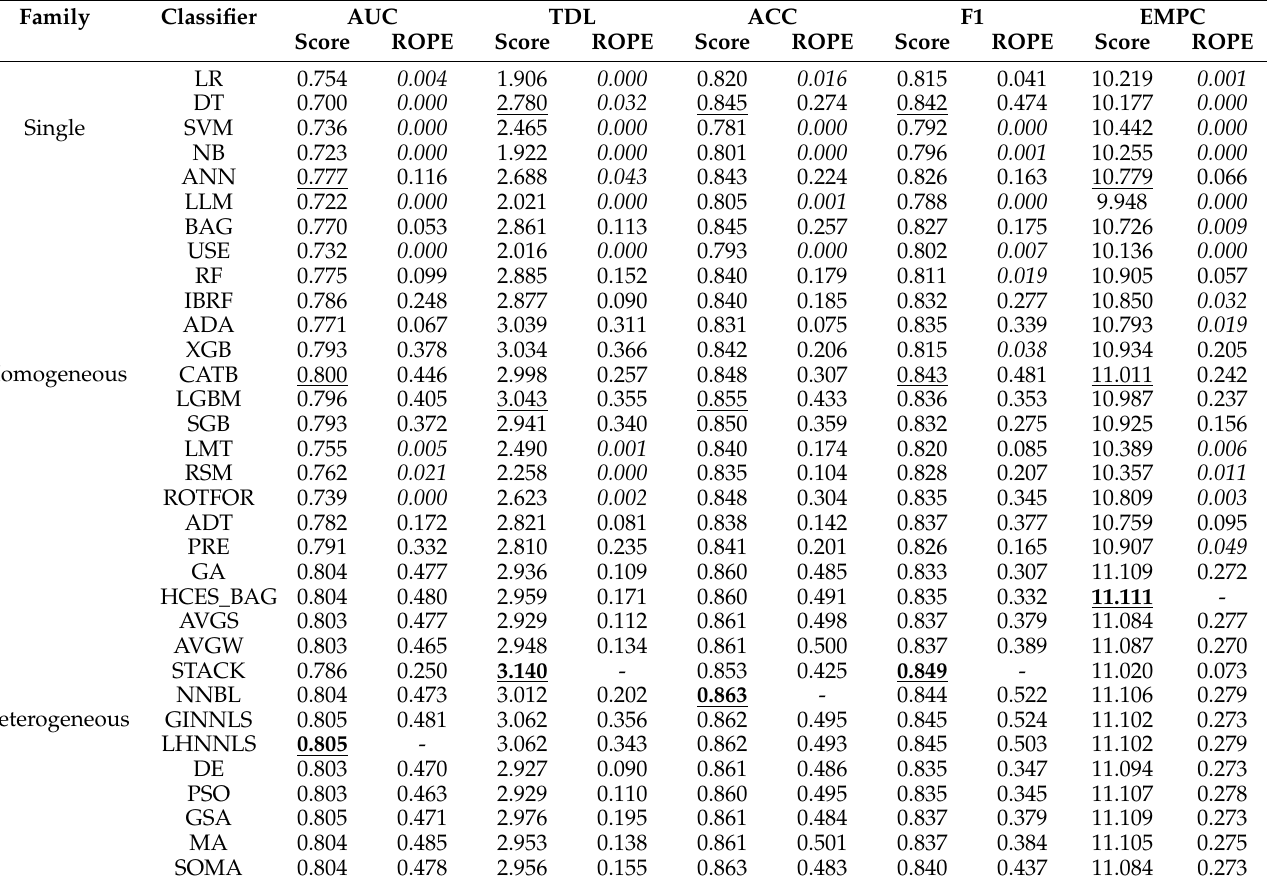
Table 9. Average performance score of each classifier together with the ROPE probabilities of the Bayesian Signed Rank test for each performance measure across. The best methods per family are underlined and the overall best methods are in bold underlined. ROPE values smaller than 0.05 are indicated in